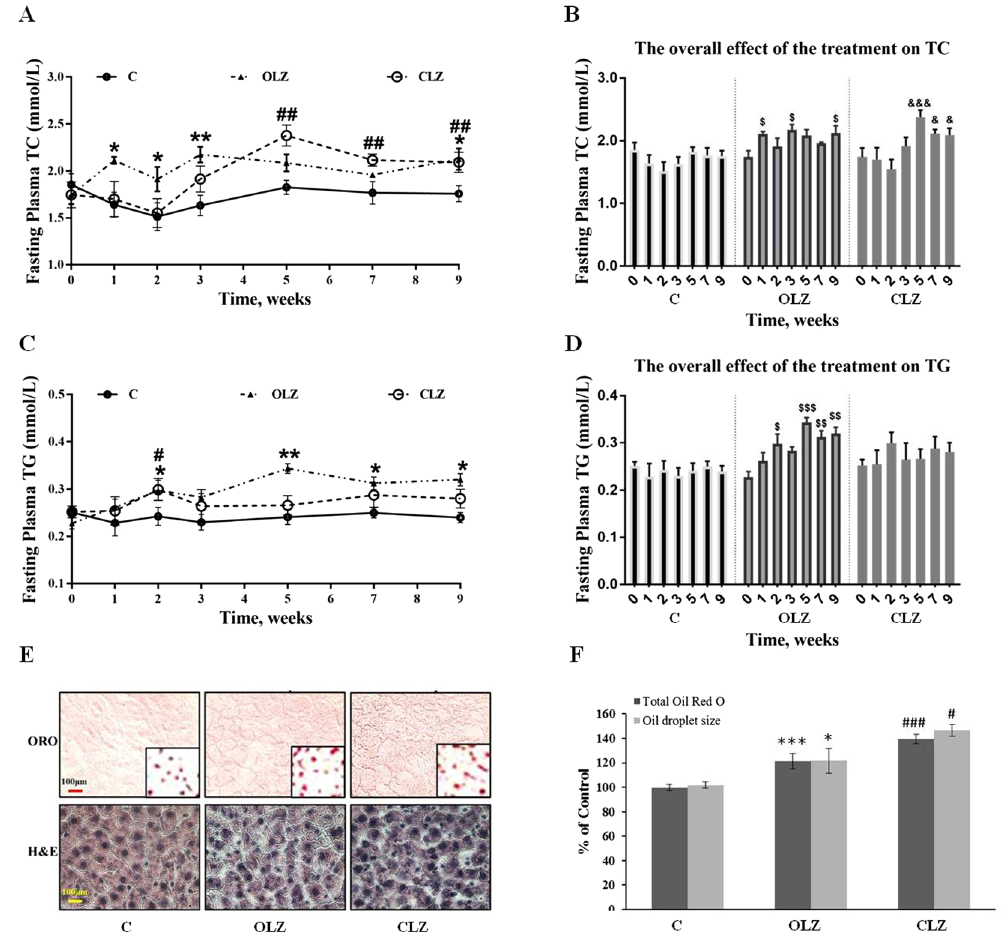
Figure 2. Chronic treatment of OLZ and CLZ led to progressive changes in blood and hepatic lipid composition. Time course of ( A ) fasting total cholesterol (TC) and ( C ) triglyceride (TG) in plasma during chronic drug treatment. The overall effect of the treatment on TC ( B ) and TG ( D ) using time as repeated measure and compared with the baseline on Week 0 of each group. ( E ) Oil Red O (ORO) and H&E staining of liver sections. Intense red colour indicates the presence of neutral lipids, mainly triglycerides. Scale bars, 100 µ m. Inset images were magnified eight times in order to highlight the lipid-staining morphology. ( F ) Lipid level of liver. The data from ORO staining are presented. Data represent mean ± SEM (n = 12 per group). * p < 0.05, ** p < 0.01, and *** p < 0.001: OLZ treatment vs. control, # p < 0.05, ## p < 0.01, and ### p < 0.001: CLZ treatment vs . control. $ p < 0.05, $$ p < 0.01, and $$$ p < 0.001: OLZ treatment vs. baseline of OLZ group. & p < 0.05 and &&& p < 0.001: CLZ treatment vs. baseline of CLZ group. C: control; OLZ: olanzapine; CLZ: